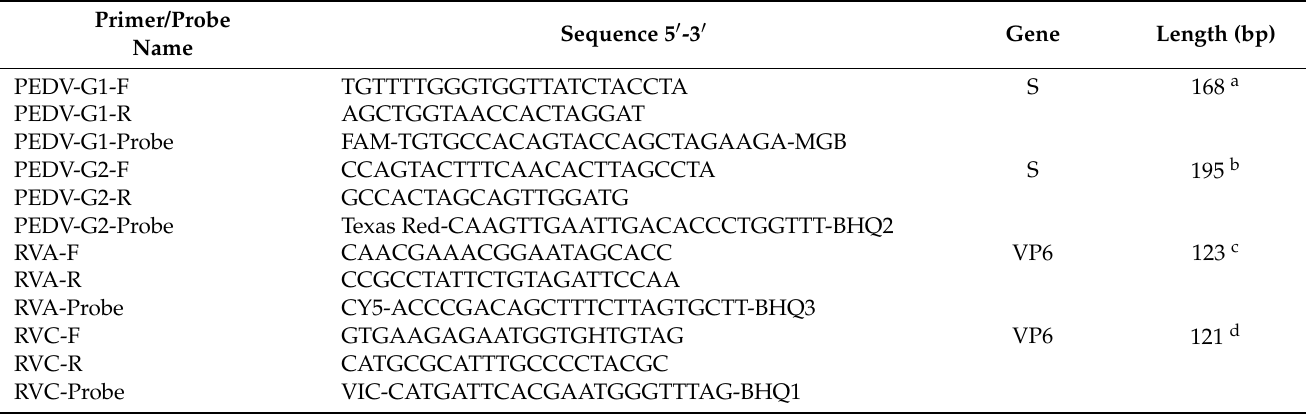
Table 1. Primers and probes for the multiplex